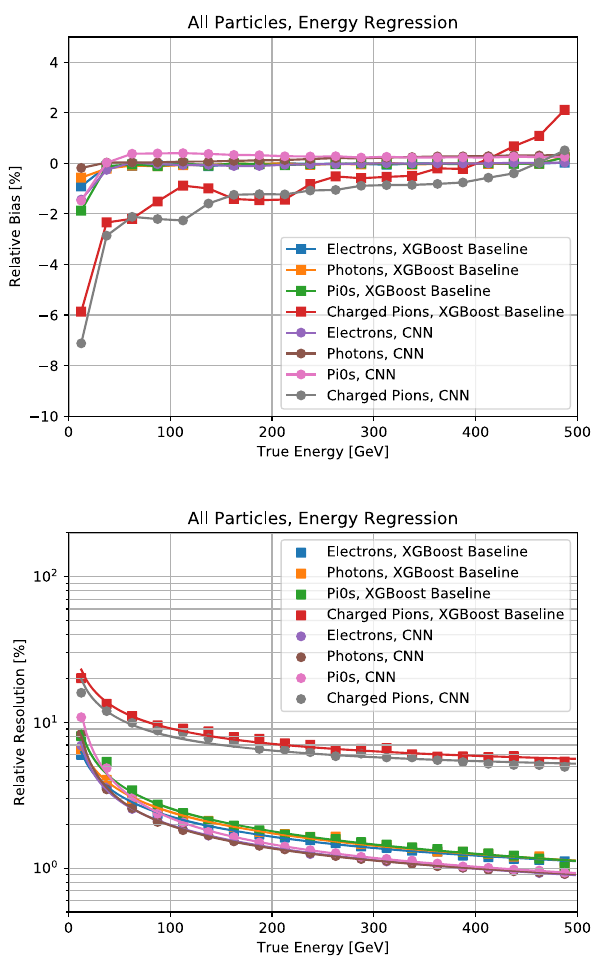
Fig. 36 Bias (top) and resolution (bottom) as a function of true energy, for electrons and photons. The particles used to train and test each algorithm are given in the